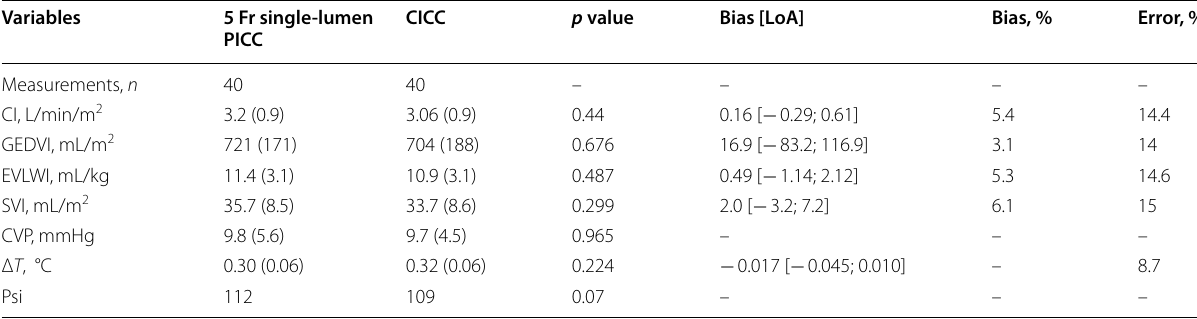
Data are reported as mean (standard deviation) CI: cardiac index; CICC: centrally inserted central catheter; CVP: central venous pressure; EVLWI: extra-vascular lung water index; GEDVI: global end-diastolic volume index; LoA: limits of agreement; PICC: peripherally inserted central catheter; Psi: pound per square inch; SVI: stroke volume index; Δ T : delta